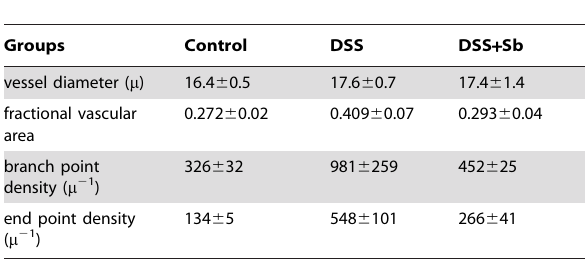
Table 1. Vascular network results (mean 6 std